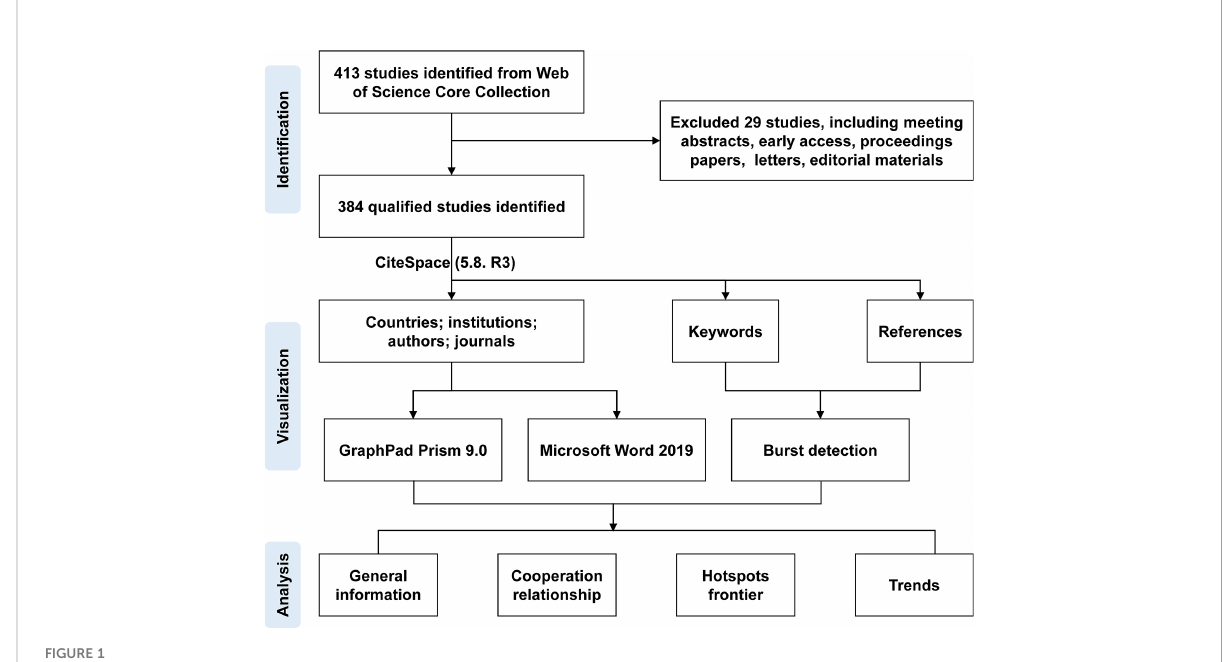
FIGURE 1 Flowchart of the